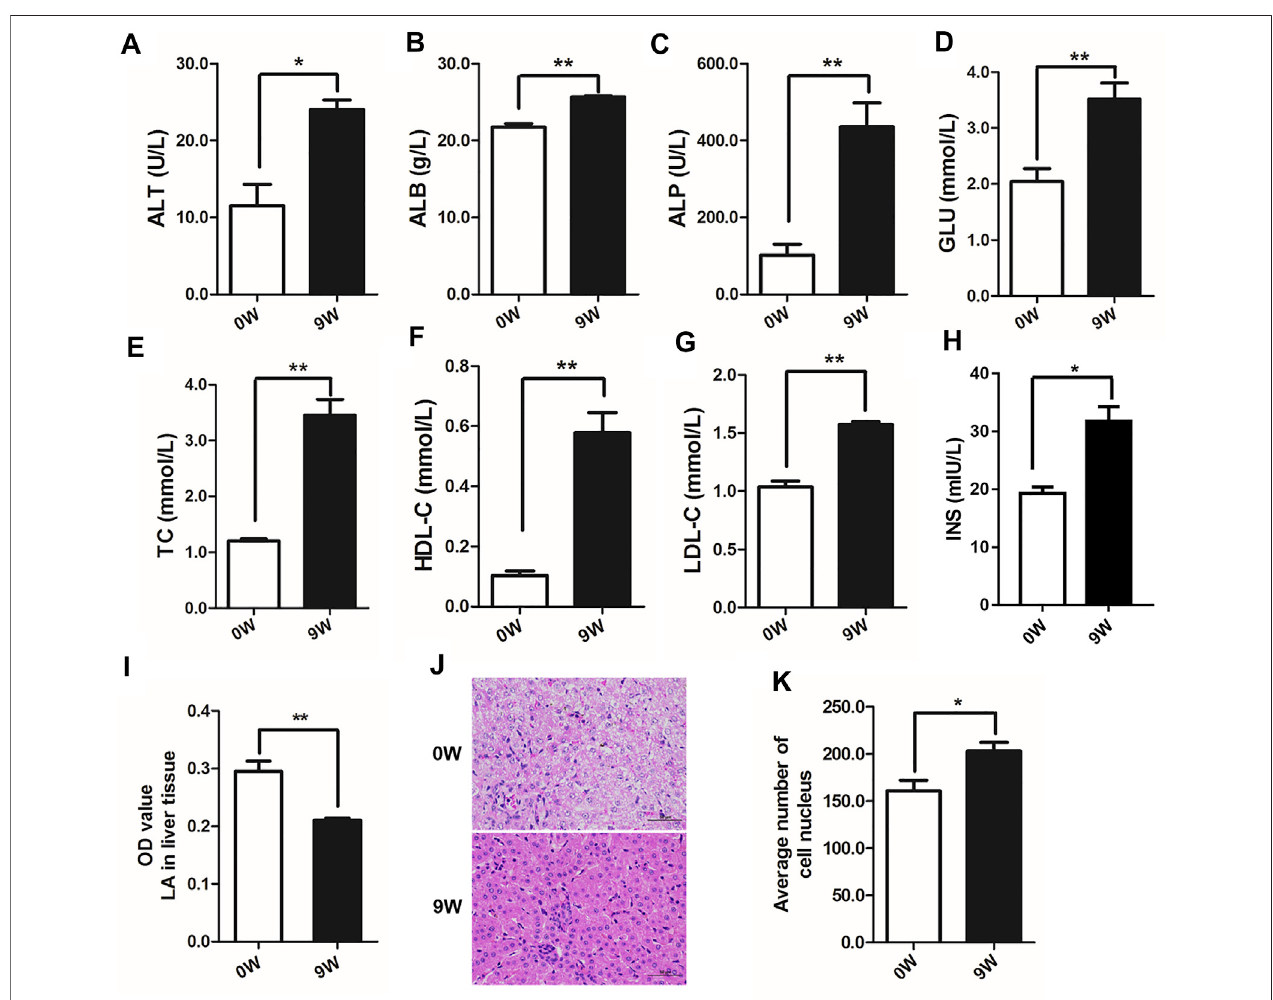
FIGURE 1 | Serum indices, hepatic lactate and histological observation of calf liver tissues from 0W and 9W animals. (A) alanine aminotransferase (ALT); (B) albumin (ALB); (C) alkaline phosphatase (ALP); (D) glucose (GLU); (E) total cholesterol (TC); (F) high-density lipoprotein cholesterol (HDL-C); (G) low-density lipoprotein cholesterol (LDL-C); (H) insulin; (I) lactate (LA) levels in liver tissues; (J) HE stained liver sections; (K) Quanti fi cation of the number of cell nuclei in liver